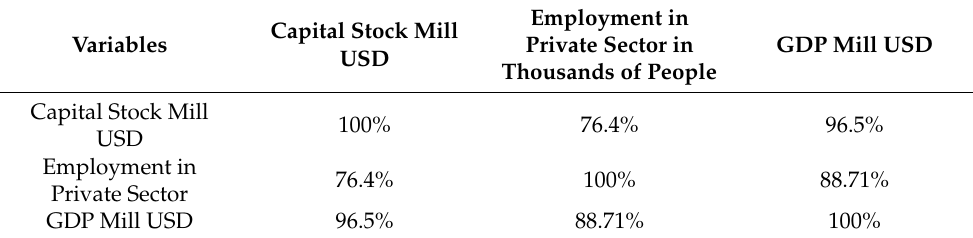
Table 1. GDP, capital stock, and employment private sector correlation with GDP